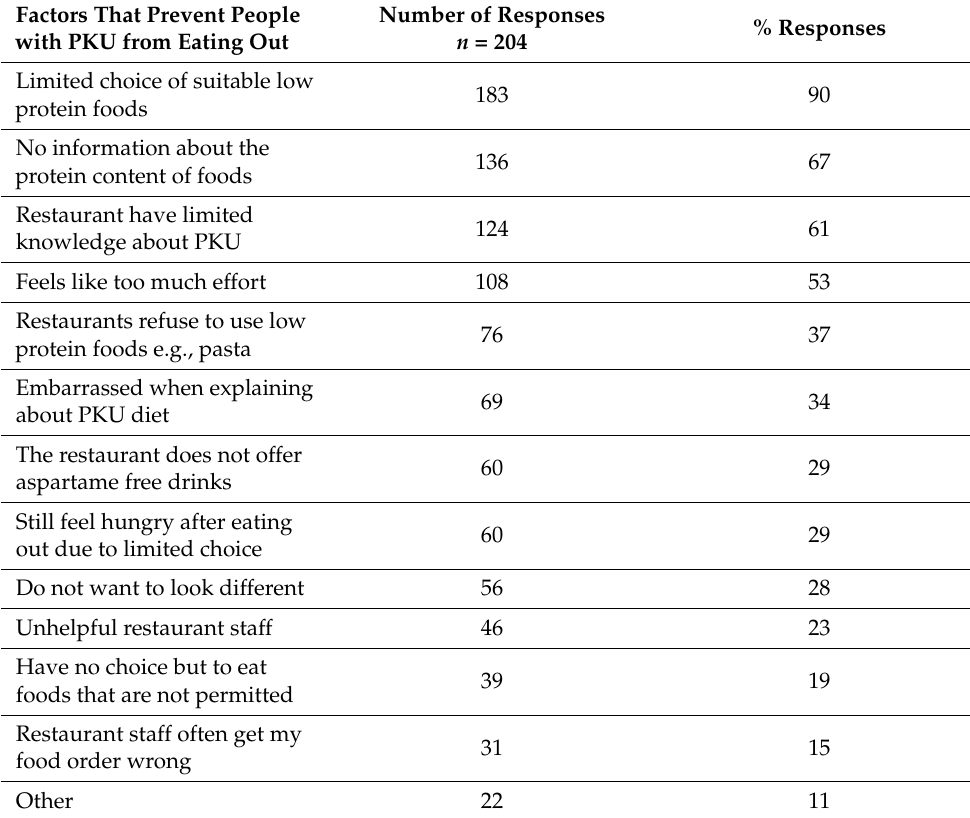
Table 1. Factors that prevent people with phenylketonuria (PKU) from eating out ( n = 204)